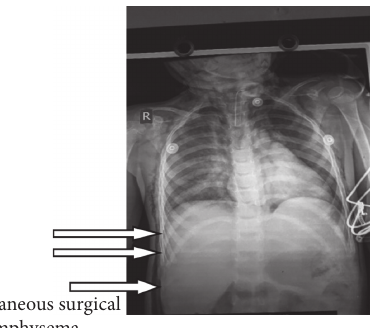
Figure 3: Postoperative chest X-ray.